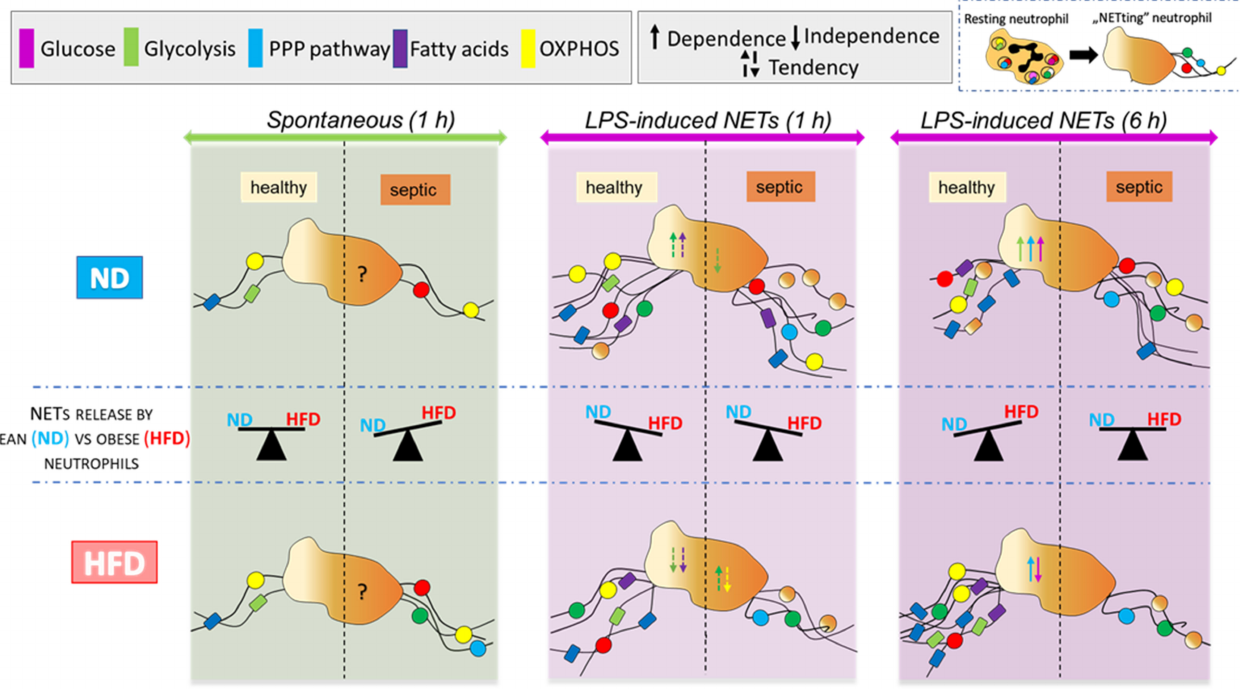
Figure 10. Key metabolic pathways/fuels regulating neutrophil extracellular trap (NET) formation by neutrophils of healthy and septic mice with obesity induced by high fat diet (HFD) and their lean controls (ND). Dependency/independency (and tendency) for glucose- (violet), glycolysis- (green), fatty acids- (navy blue), pentose phosphate pathway- (PPP, blue), oxidative phosphorylation-involvement (OXPHOS, yellow) in NET formation were marked with arrows in the corresponding colors. Short-term spontaneous (light green panel) and lipopolisaccharide (LPS)-induced (1 h, pink panel) NETs release was studied as well as long-term (6 h, pink panel) LPS-induced NETs were compared differences between them are presented as balanced/unbalanced